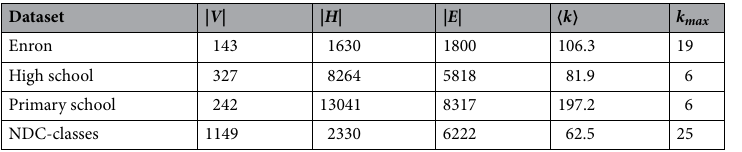
Table 1. Basic properties of the real-world datasets we use are provided here. | V | is the number of vertices, | H | is the number of hyperedges, | E | is the number of edges in the projected graph, (cid:31) k (cid:30) is the average weighted degree, and k max is the maximum hyperedge size.